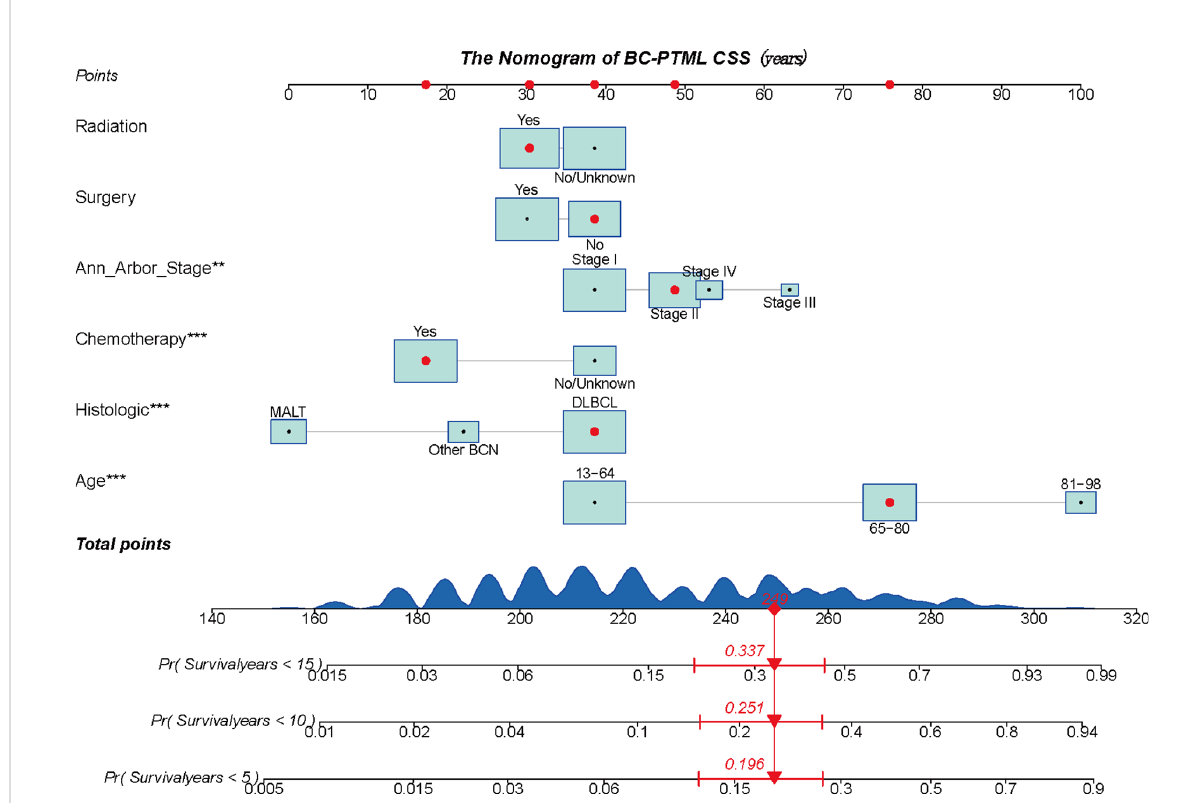
FIGURE 3 A constructed nomogram to predict the outcome of one patient with BC-PTML. The patient was 66 years of age, white, female, diagnosed with DLBCL, married, classi fi ed as Ann Arbor Stage II, did not have surgery, and did receive chemotherapy and radiotherapy. The importance of each variable was ranked according to the standard deviation along the nomogram scales. To use the nomogram, the speci fi c points (black dots) of individual patients are located on each variable axis. The sum (n=249) of these points is located on the Total Points axis, and a line is drawn downward to the survival axis to determine the probability of 5-year (80.4%), 10-year (74.9%), and 15-year (66.3%) overall survival. BC-PTML, B cell primary thyroid malignant lymphoma. ** < 0.01, *** <